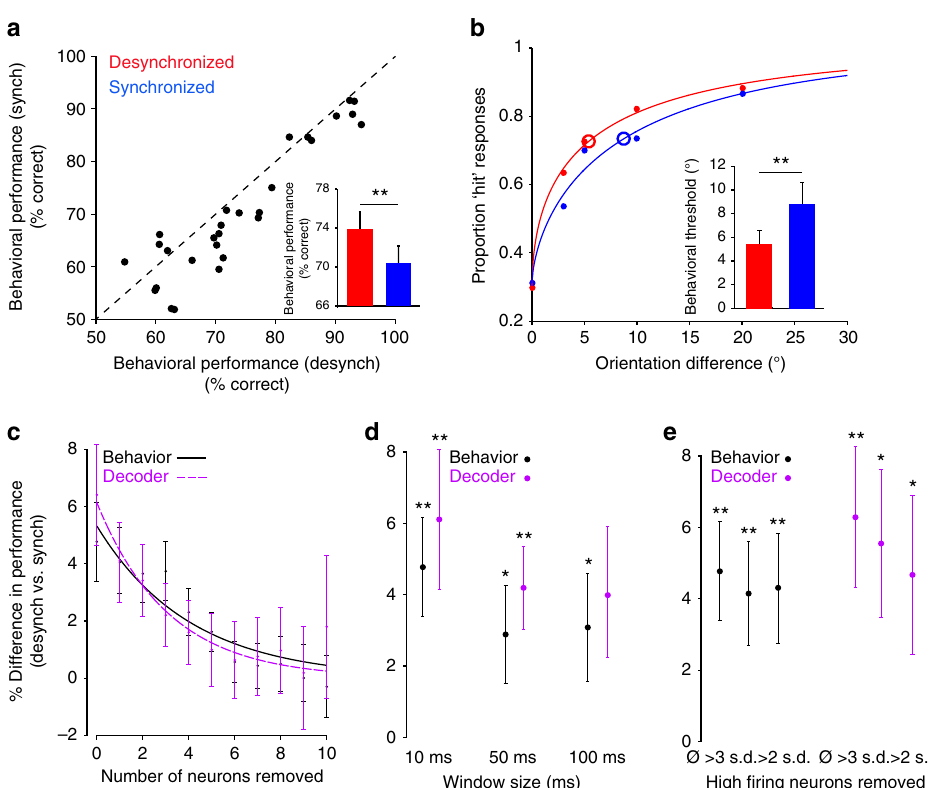
Fig. 3 Population synchrony impacts behavioral performance. a Scatter plot of the behavioral performance (% correct responses) in synchronized vs. desynchronized trials. Each point represents one session. Inset, mean behavioral performance is signi fi cantly higher in desynchronized trials (** P < 0.001). Error bars represent standard error. b Psychometric curves associated with the synchronized and desynchronized cortical states. Large circles represent the psychometric thresholds. Solid dots represent the cumulative proportion of hit responses across trials and sessions for each orientation difference. We did not include the 2° orientation difference since it was only used in four sessions (however, the difference in the proportion of hit responses between desynch vs. synch trials was 5.6%). Inset, average behavioral performance threshold is signi fi cantly lower in desynchronized trials (** P < 0.005). c Percent difference in behavioral and decoder performance between the desynchronized and synchronized trials using the cell-dropping procedure (behavior: black; decoder: purple). The two curves represent exponential fi ts. Error bars represent standard error. d Percent difference in behavioral and decoder performance between desynchronized and synchronized trials for different window sizes to de fi ne PSI (** P < 0.005, * P < 0.05). e Percent difference in behavioral and decoder performance between desynchronized and synchronized trials after removing the high- fi ring rate (outlier) neurons from the population. Ø represents no neurons removed, > 3 s.d. and > 2 s.d. represent removing neurons with average spontaneous fi ring rates > 3 s.d. and 2 s.d. above the population mean (** P < 0.005, * P <